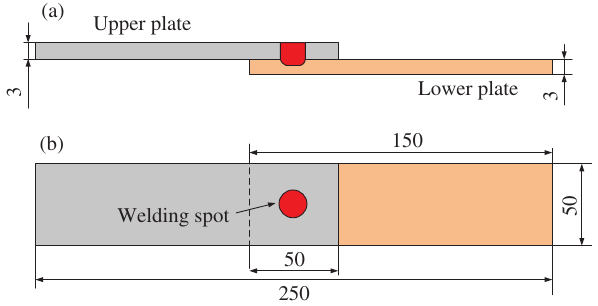
Figure 1: Schematic of the joint (unit